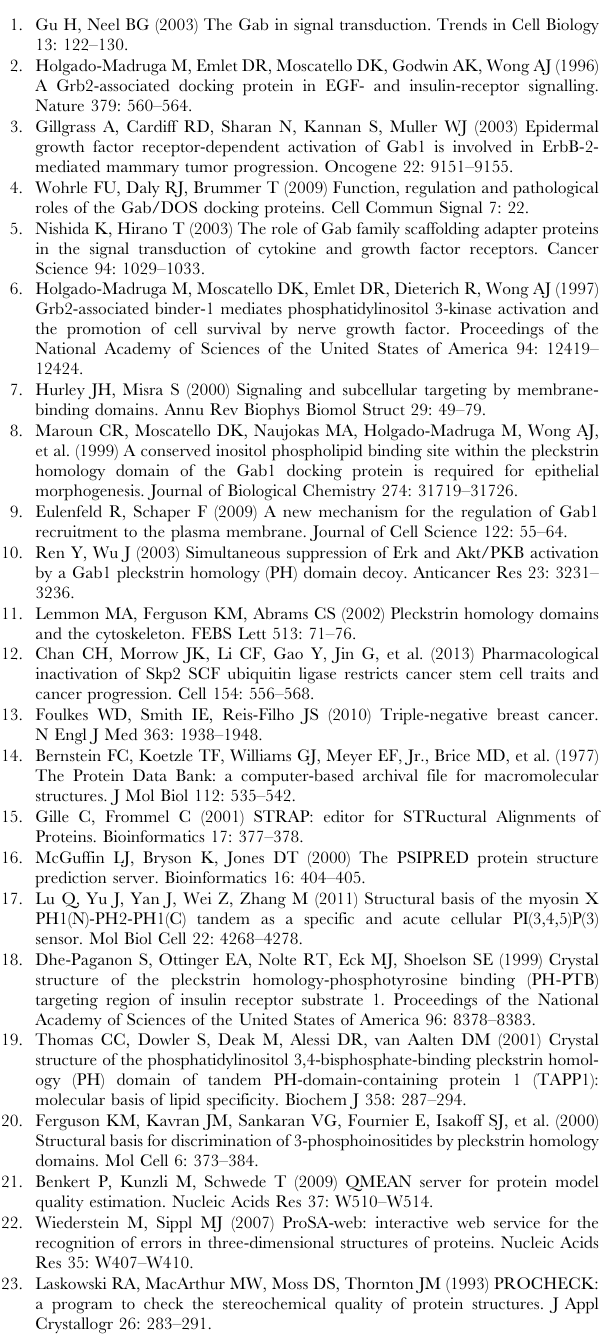
S2 Table The crystal structures employed to generate PSSM. S3 Table PSSM profile for PH domain ( b 1 , b 2 , b 3 , b 6 , b 7 and a 1